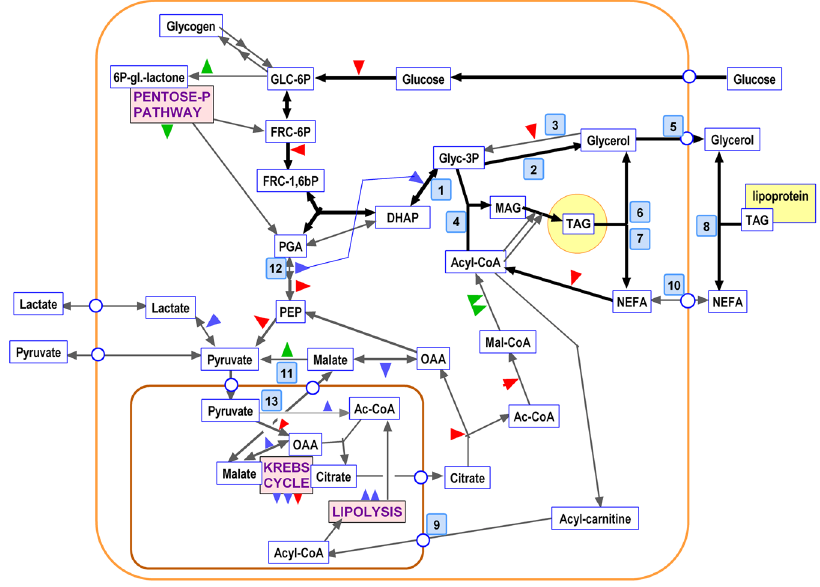
Figure 4. Main metabolic pathways affecting glycerol in the context of glucose-fatty acid metabolism in the adipocyte. The graph presents the main intermediate metabolites and substrates. Wide lines correspond to main pathways activated by incubation with glucose, whilst thin lines represent inhibited pathways. The figure represents the situation of the adipocyte during incubation with glucose, and have incorporated the data from label fate, metabolite concentrations, specific radioactivity and gene expression. Red triangles represent ATP, blue triangles represent NADH, and green triangles NADPH; in all cases, utilization by the path is represented by the tip pointing to the line, and synthesis or production by the tip pointing away from the line. The blue line represents the alternative use of phosphoglycerate dehydrogenase-generated NADH by glycerol-P dehydrogenase instead of lactate dehydrogenase as described in the text. The blue squares with numbers represent the proteins/genes controlling the corresponding path: 1- Gpd1 (glycerol-3P dehydrogenase); 2- Pgp (glycerophosphatase); 3- Gk (glycerokinase); 4- Gpam (glycerol-3P acyl-transferase); 5- Aqp7 (aquaporin 7); 6 Hsl (hormone-sensitive lipase); 7- Atgl (TAG lipase, adipose tissue); 8- Lpl (lipoprotein lipase); 9- Cpt1b (carnitine-palmitoleyl transferase); 10- Cd36 (CD36 fatty acid transporter); 11- Me1 (NADP-dependent malic enzyme); 12- Phgdh (3-phosphoglycerate dehydrogenase); 13- Pdk4 (pyruvate dehydrogenase kinase